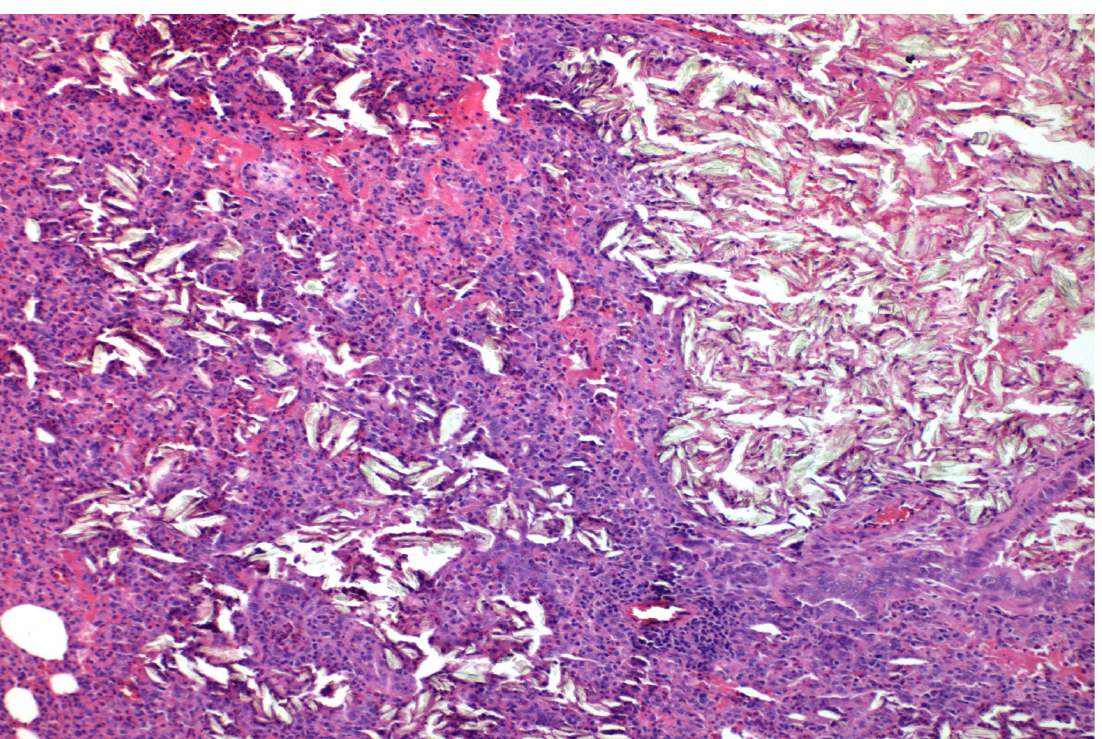
Figure 2. ×40 Masson-Trichrome stain: Following talc installation, fibrosis is present under the mesothelial layer.